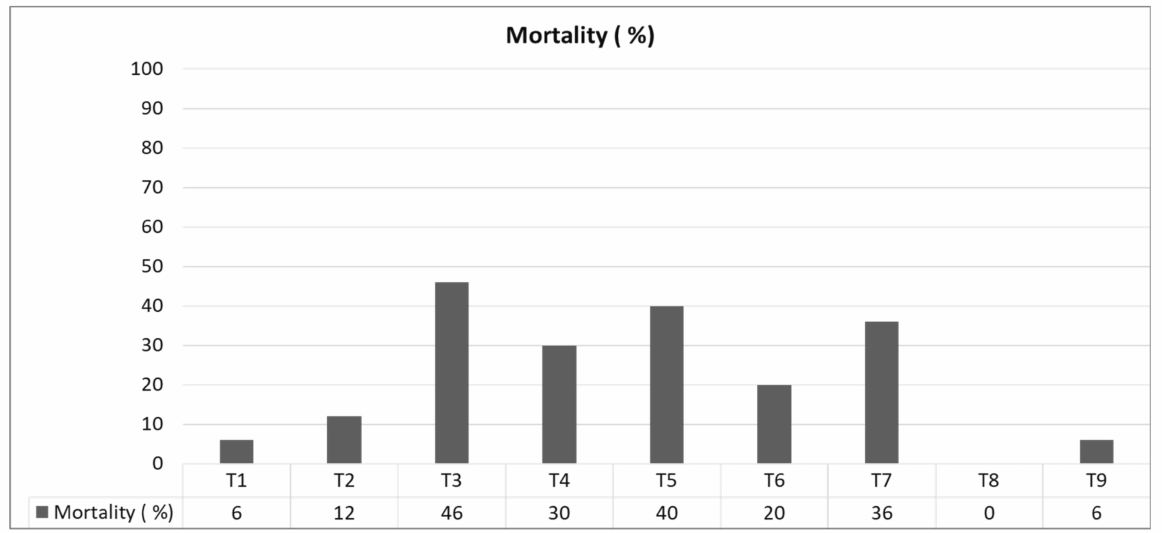
Figure 6. Mortality rate in nursery oil palms inoculated with isolates of Ganoderma obtained from oil palms affected by BSR in northern Colombia after 29